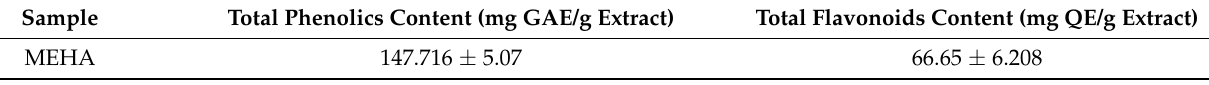
Table 1. Total phenolics and flavonoids content of